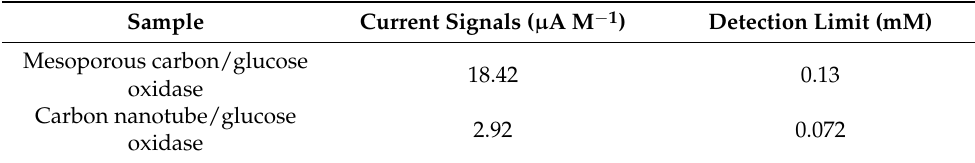
Table 8. Characteristic of the prepared electrodes for a glucose